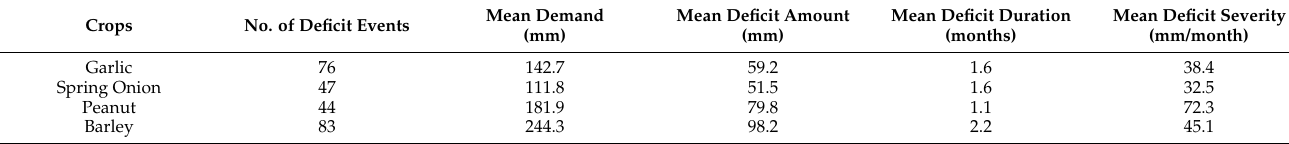
Table 4. Basic statistics of agricultural water deficit for the four crops considered in this study. Crops No. of Deficit Events Mean Demand